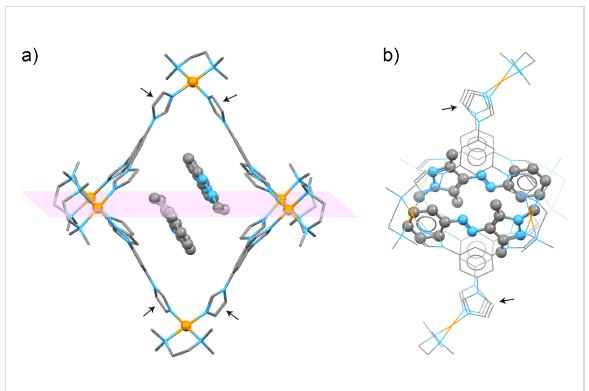
Figure 3: Front view (a) and side view (b) of the X-ray crystal struc- ture of ( E - 1 ) 2 2 (major conformations of 1 and 2 ; see also Supporting Information File 1, Figures S15 and S16). The horizontal plane (pink) denotes the positions of eight equatorial imidazole groups; four axial imidazoles are denoted by black arrows. Color codes: C, gray; N, blue; Pd, orange. Hydrogens, counterions, and solvent molecules are not shown for clarity.